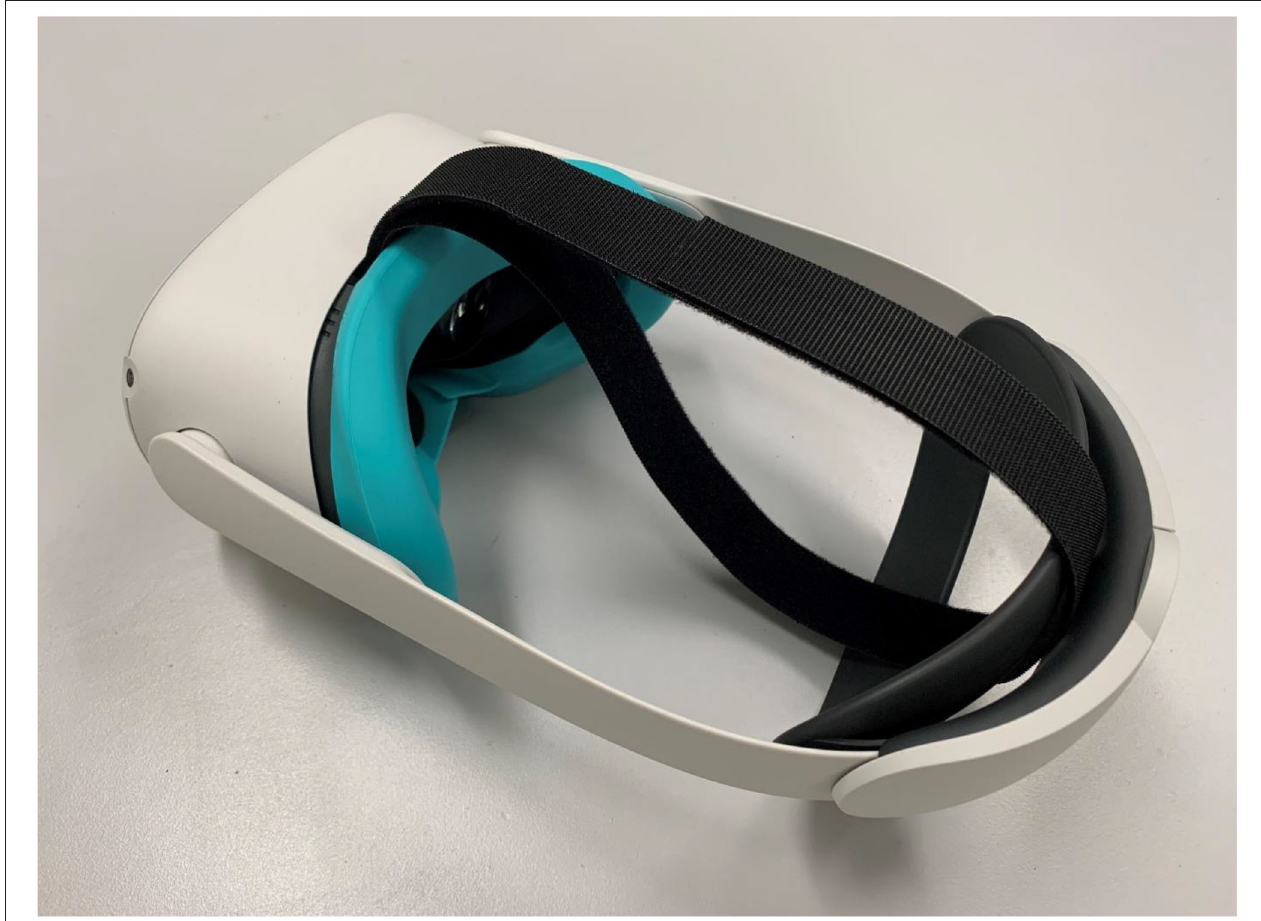
FIGURE 1 | Oculus Quest 2 with non-absorbent wipeable facial interface with replaceable silicone cover and replaceable and washable Velcro securing strap.